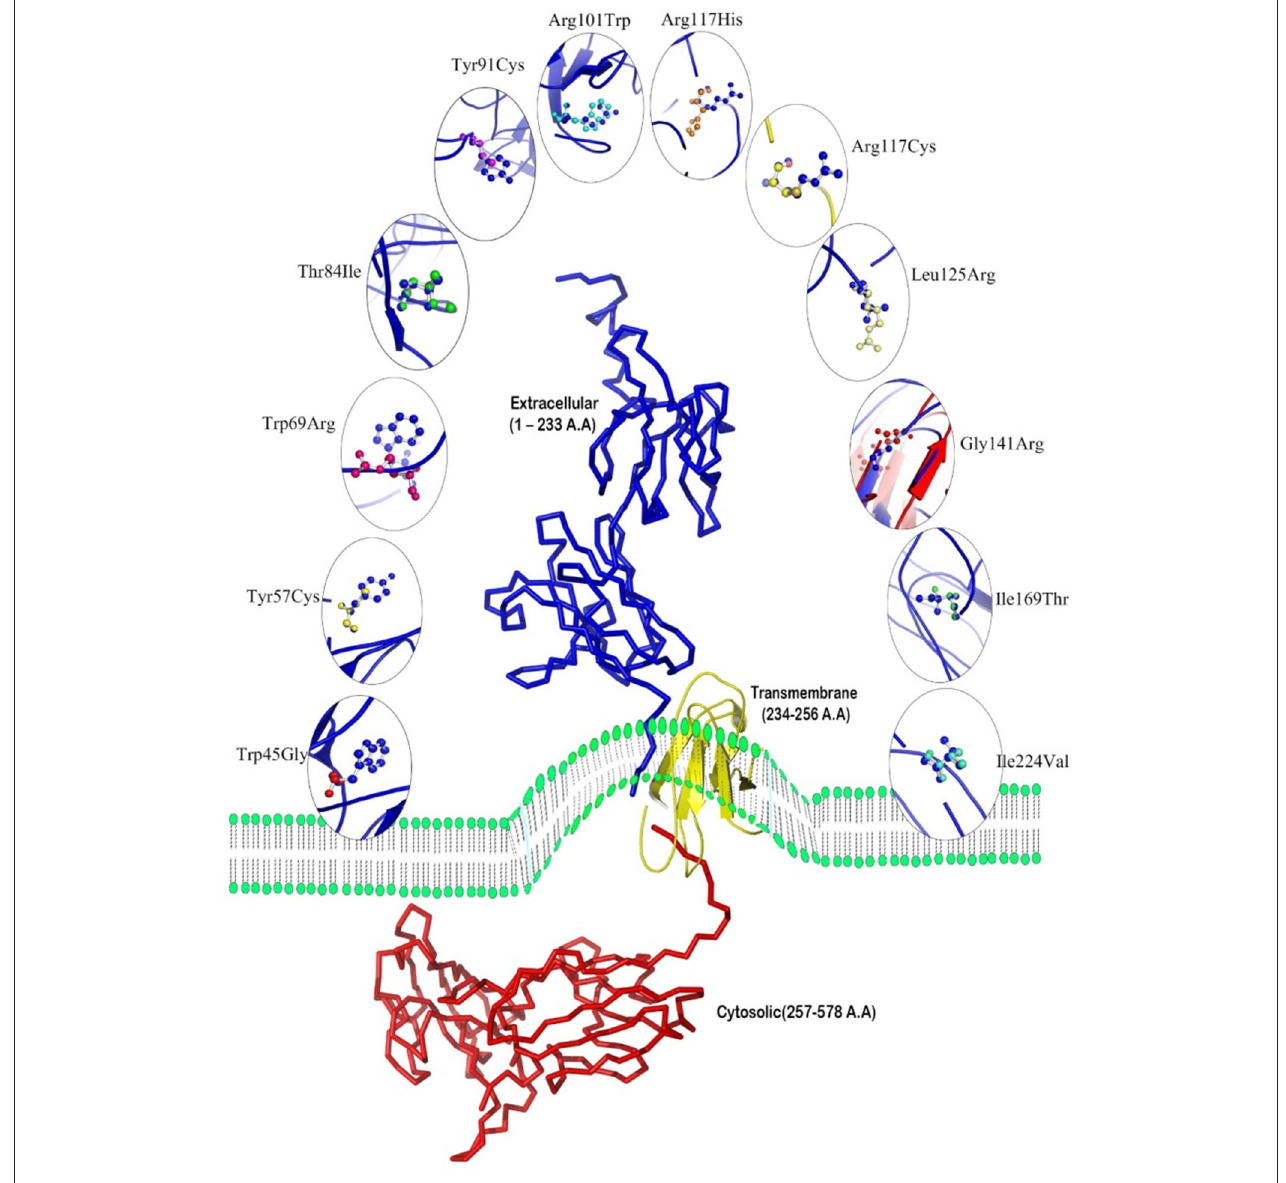
FIGURE 3 | Overview of 12 mutated models with superpose center figure. The IL10RA models represented in cartoon and mutated amino acids are represented non-green colored in sticks.